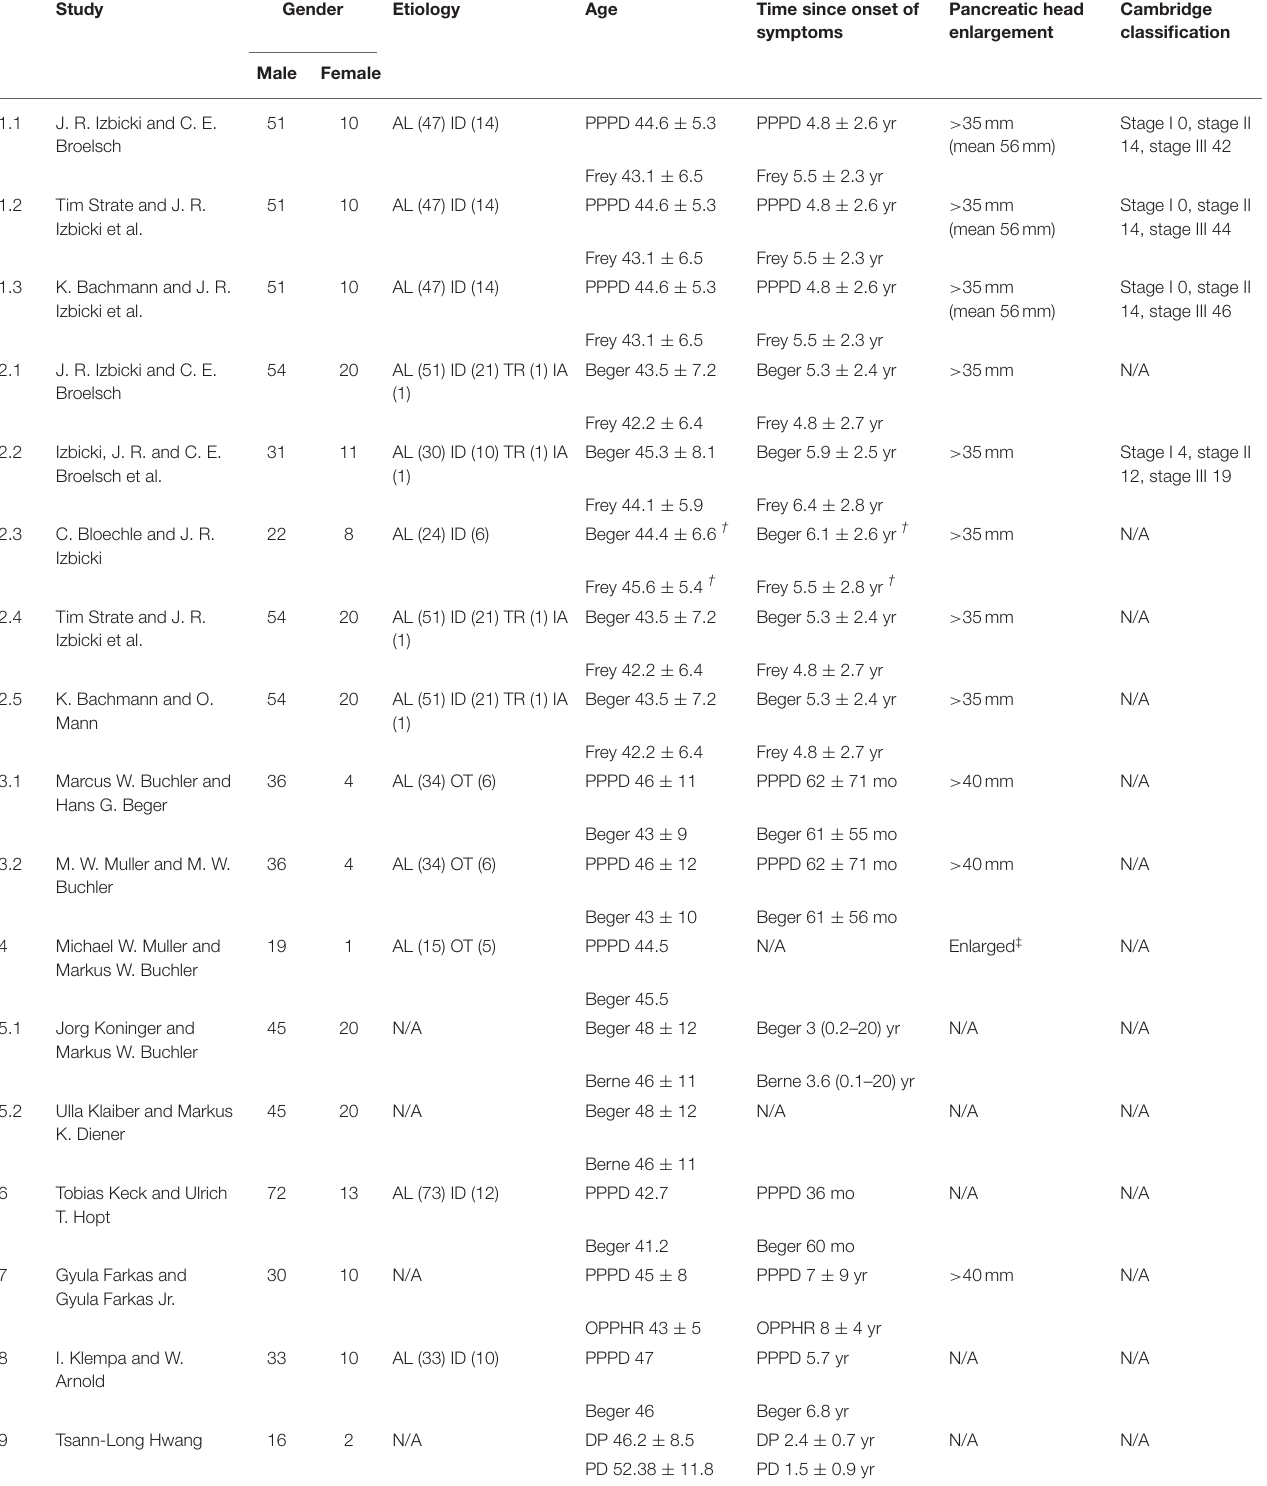
TABLE 2 | Baseline patient demographics for all included studies. Study Gender Etiology Age Time since onset of